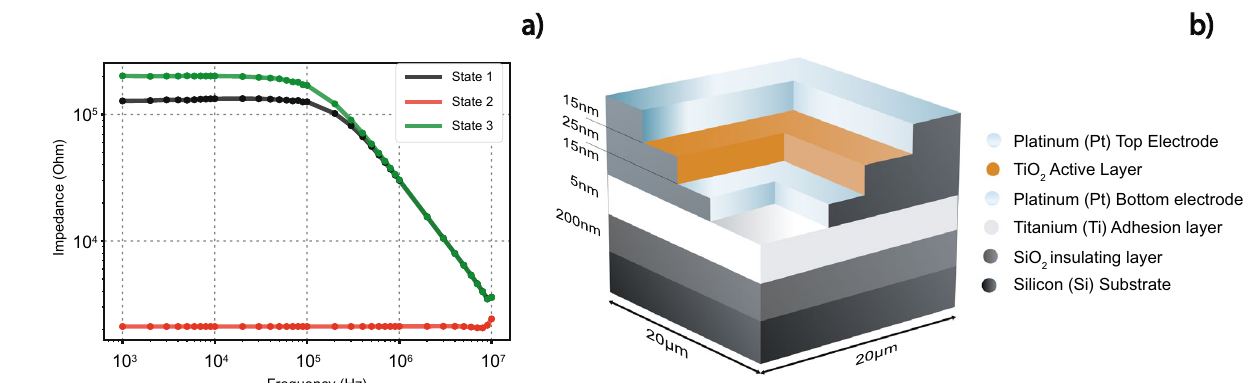
Figure 2. In subfigure ( a ) Typical curves resulting from frequency sweeps are presented. State 1 is the initial measurement, used to locate possible inconsistencies and deviations from expected behaviour. State 2 is the resulting frequency sweep after a switching event, while state 3 is the resulting frequency sweep from a second switching event of the opposite polarity. Subfigure ( b ) depicts the multiple layers which compose the Metal Insulator Metal (MIM) structure of a metal oxide memristor, such as the one used to extract data for Subfigure ( a